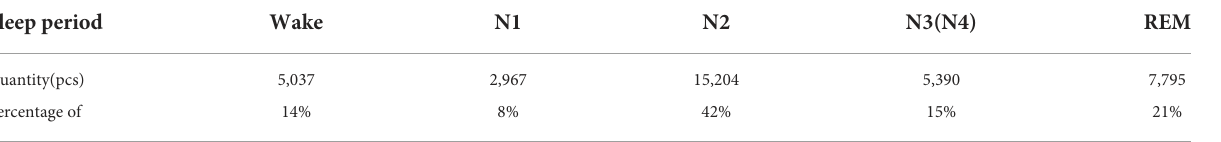
TABLE 1 Amount of data for each sleep stage in the experimental data. Sleep